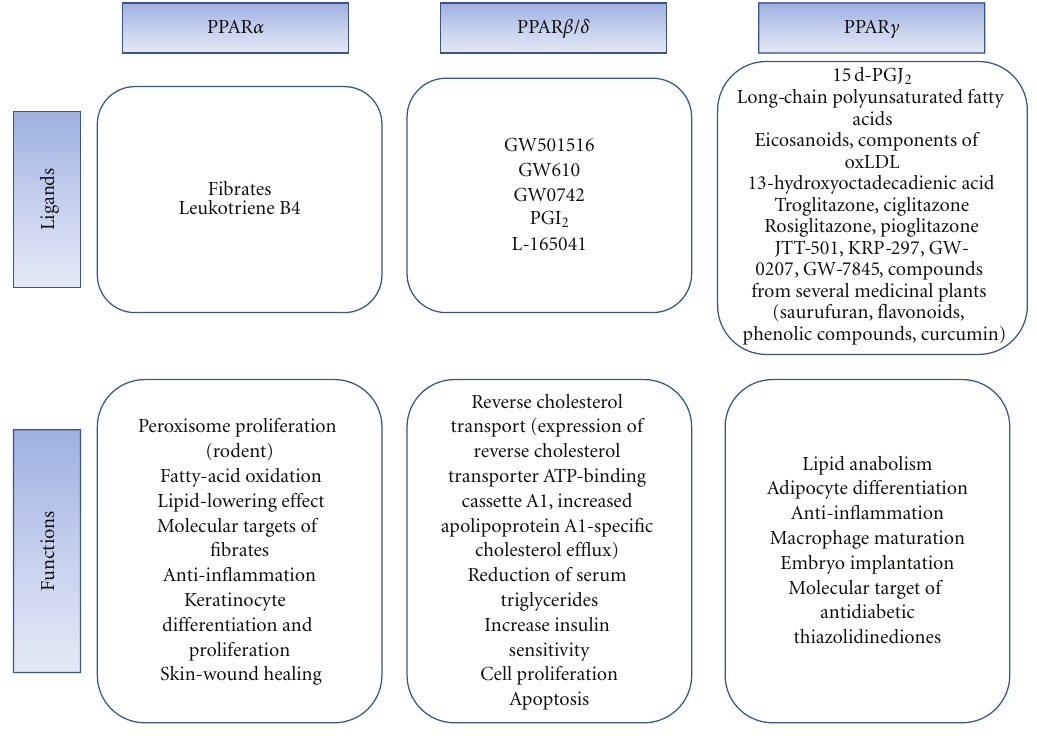
Figure 1: Summary of ligands and functions of each PPAR.